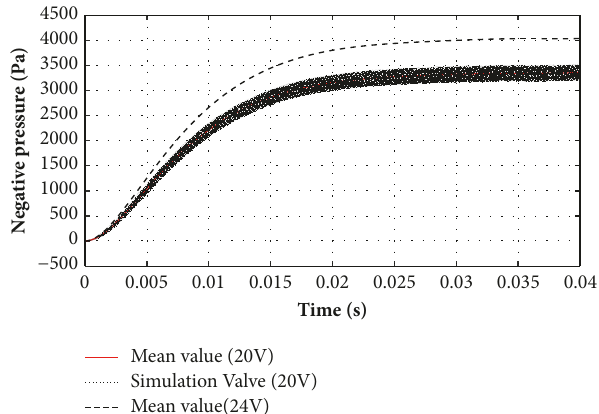
Figure 17: Negative pressure response simulation curve.